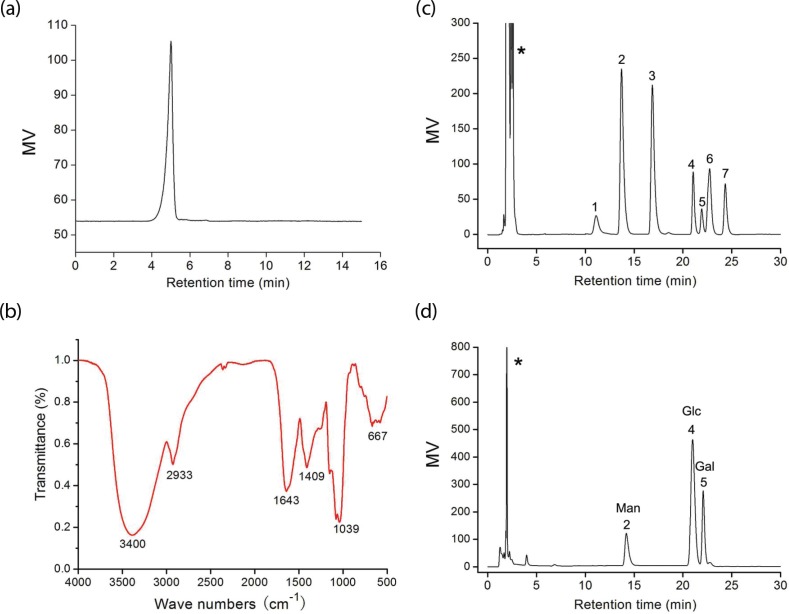
(a) HPLC chromatogram of SAP; (b) FT-IR spectrum of SAP; (c) a standard mixture of monosaccharides; (d) analysis of monosaccharide composition of SAP (*-solvent peak, 1-fructose, 2-mannose, 3-rhamnose, 4-glucose, 5-galactose, 6-xylose, and 7-fucose).